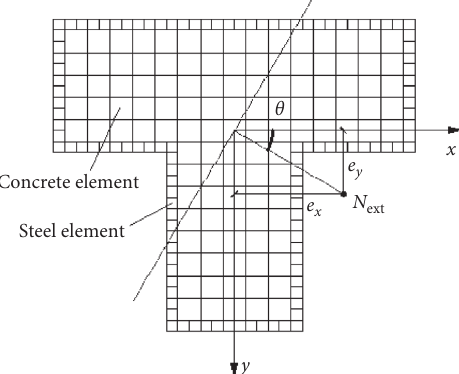
Figure 2: Element division of cross section and axial load